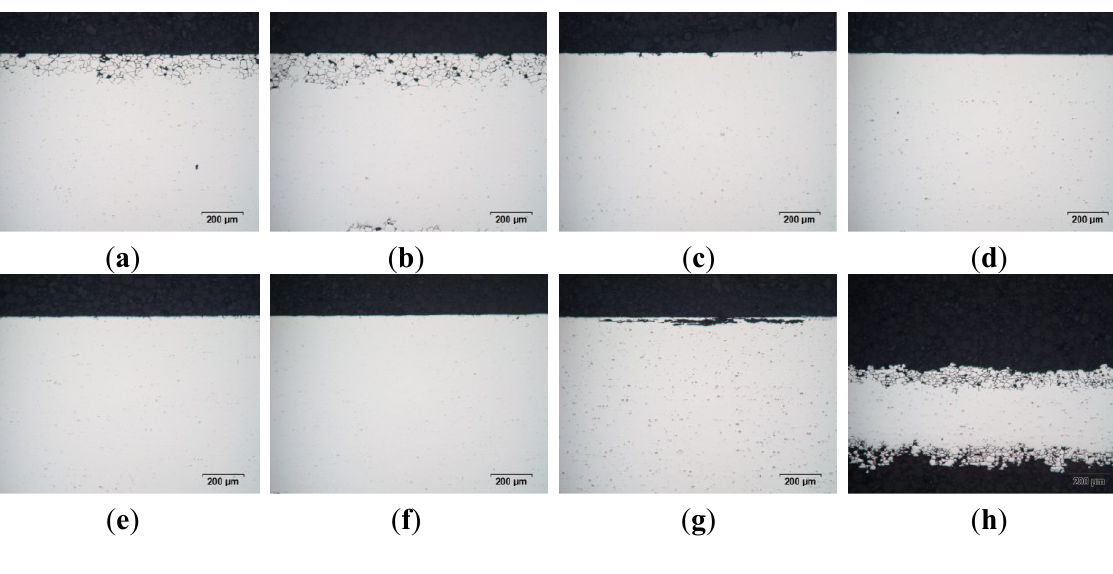
Figure 14. Corrosion behavior in temper T4* and temper T6*. ( a ) AA6016–1.10